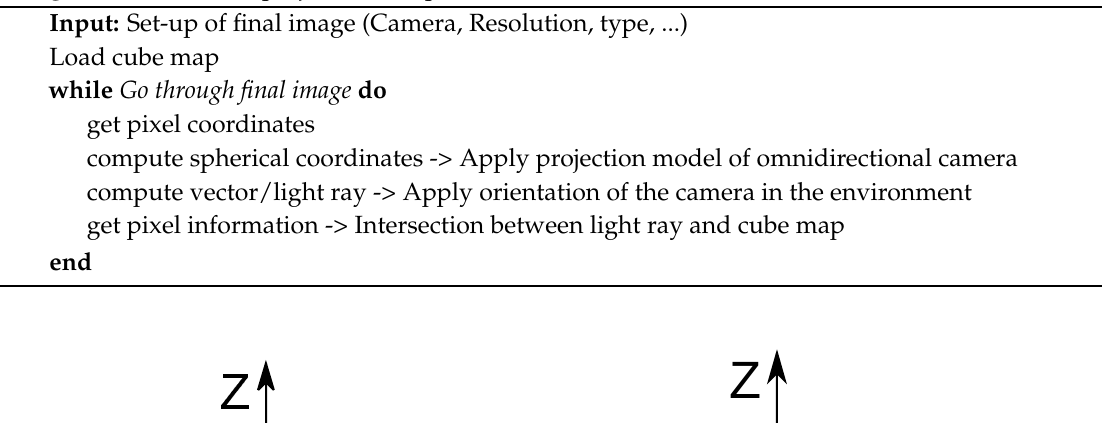
Algorithm 1: Central-projection composition